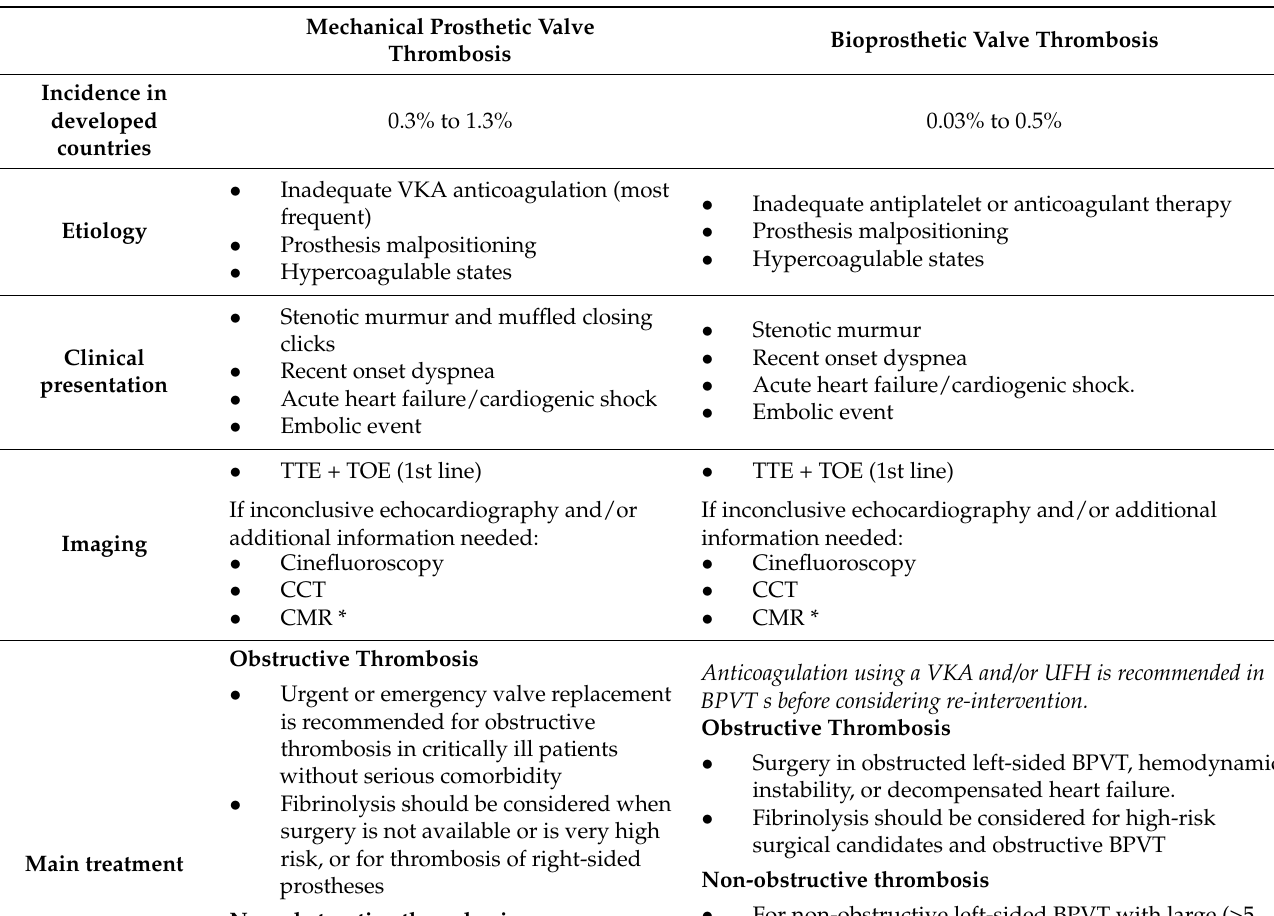
Table 1. Mechanical vs. bioprosthetic valve thrombosis [2,10–16]. BPVT: bioprosthetic valve